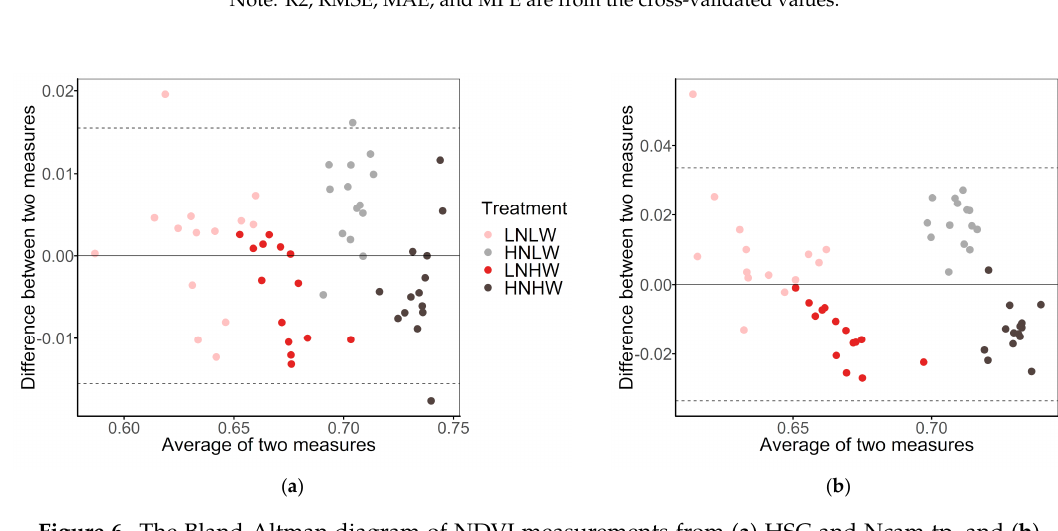
Figure 6. The Bland-Altman diagram of NDVI measurements from ( a ) HSC and Ncam tp, and ( b ) HSC and Ncam lp using the model of MLR. LNLW, low nitrogen and drought-stressed. HNLW, high nitrogen and drought-stressed. LNHW, low nitrogen and well-watered. HNHW, high nitrogen and well-watered.